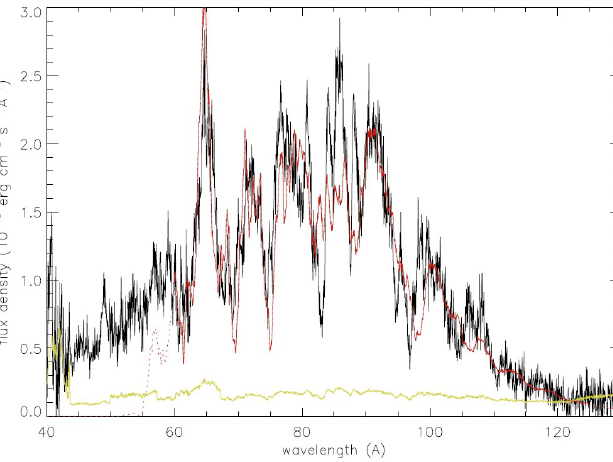
Figure 3: The Chandra LETG spectrum of SS Cyg in outburst (thick black curve) and the best-fit model atmosphere spectrum with T eff = 190 kK, log g = 6 . 2, and log N H = 19 . 9 (thin red curve). The fitting was per- formed in the 60–125 ˚A wavelength range. The model spectrum at shorter wavelengths is shown by the dashed red curve.